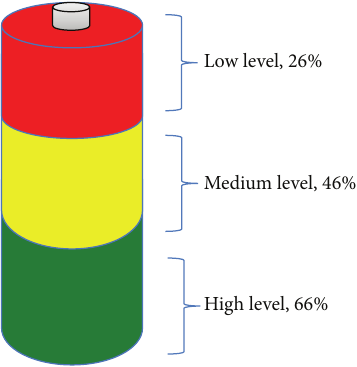
Figure 6: Limit of battery